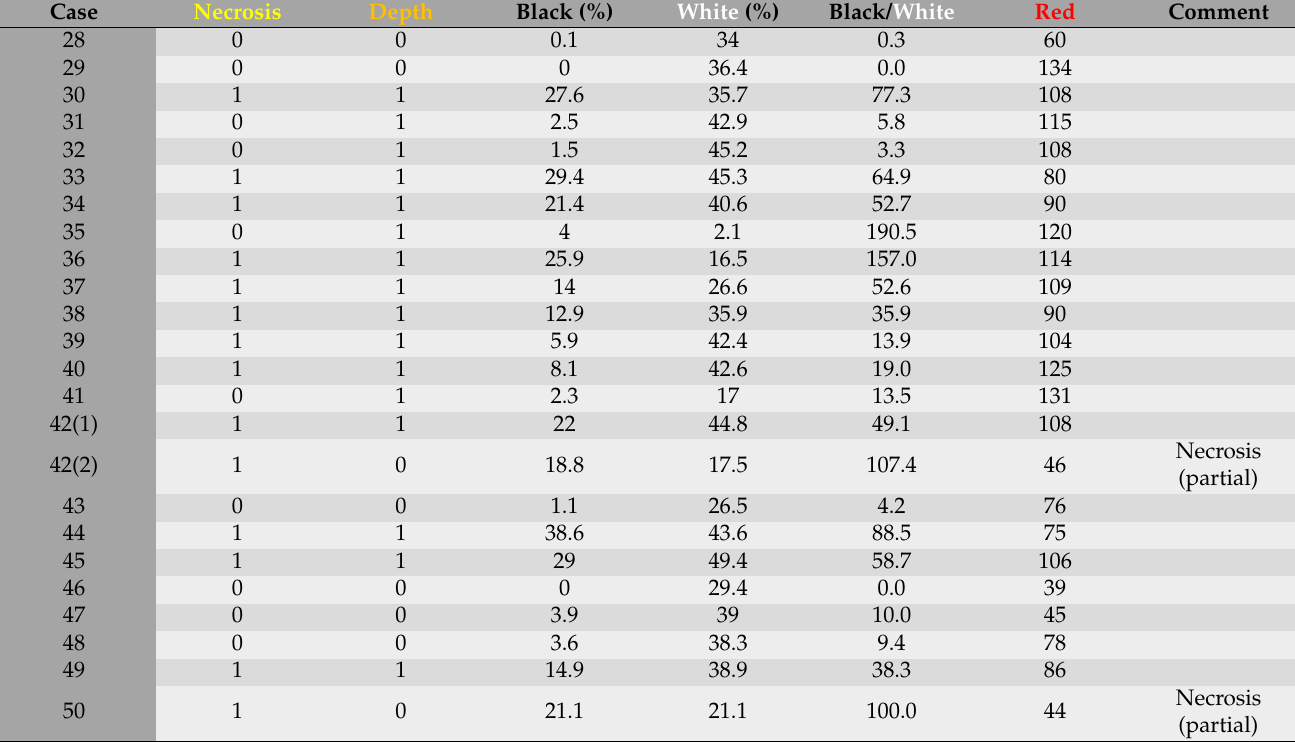
Table 5. Data of 23 additional cases with decubitus